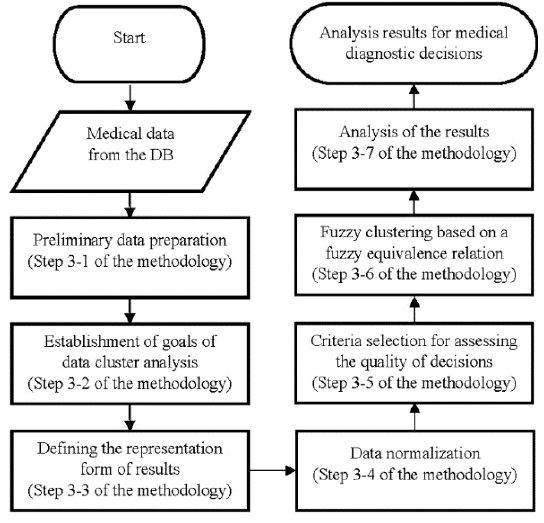
Figure 2. A flowchart explaining the